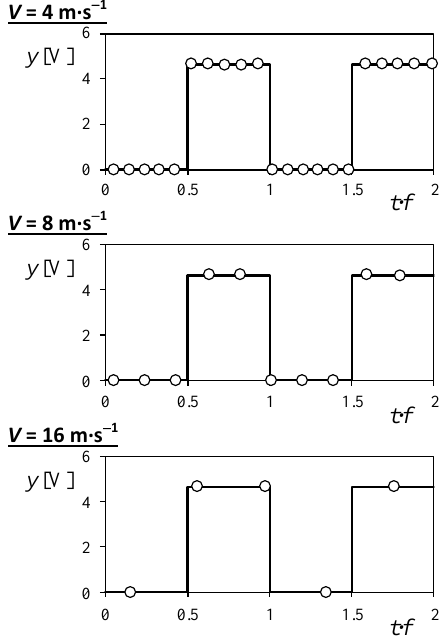
Figure 15. Number sample points (open circles) measured with ABDAS into three 2-period brackets of the three tested cup anemometers’ output signal.